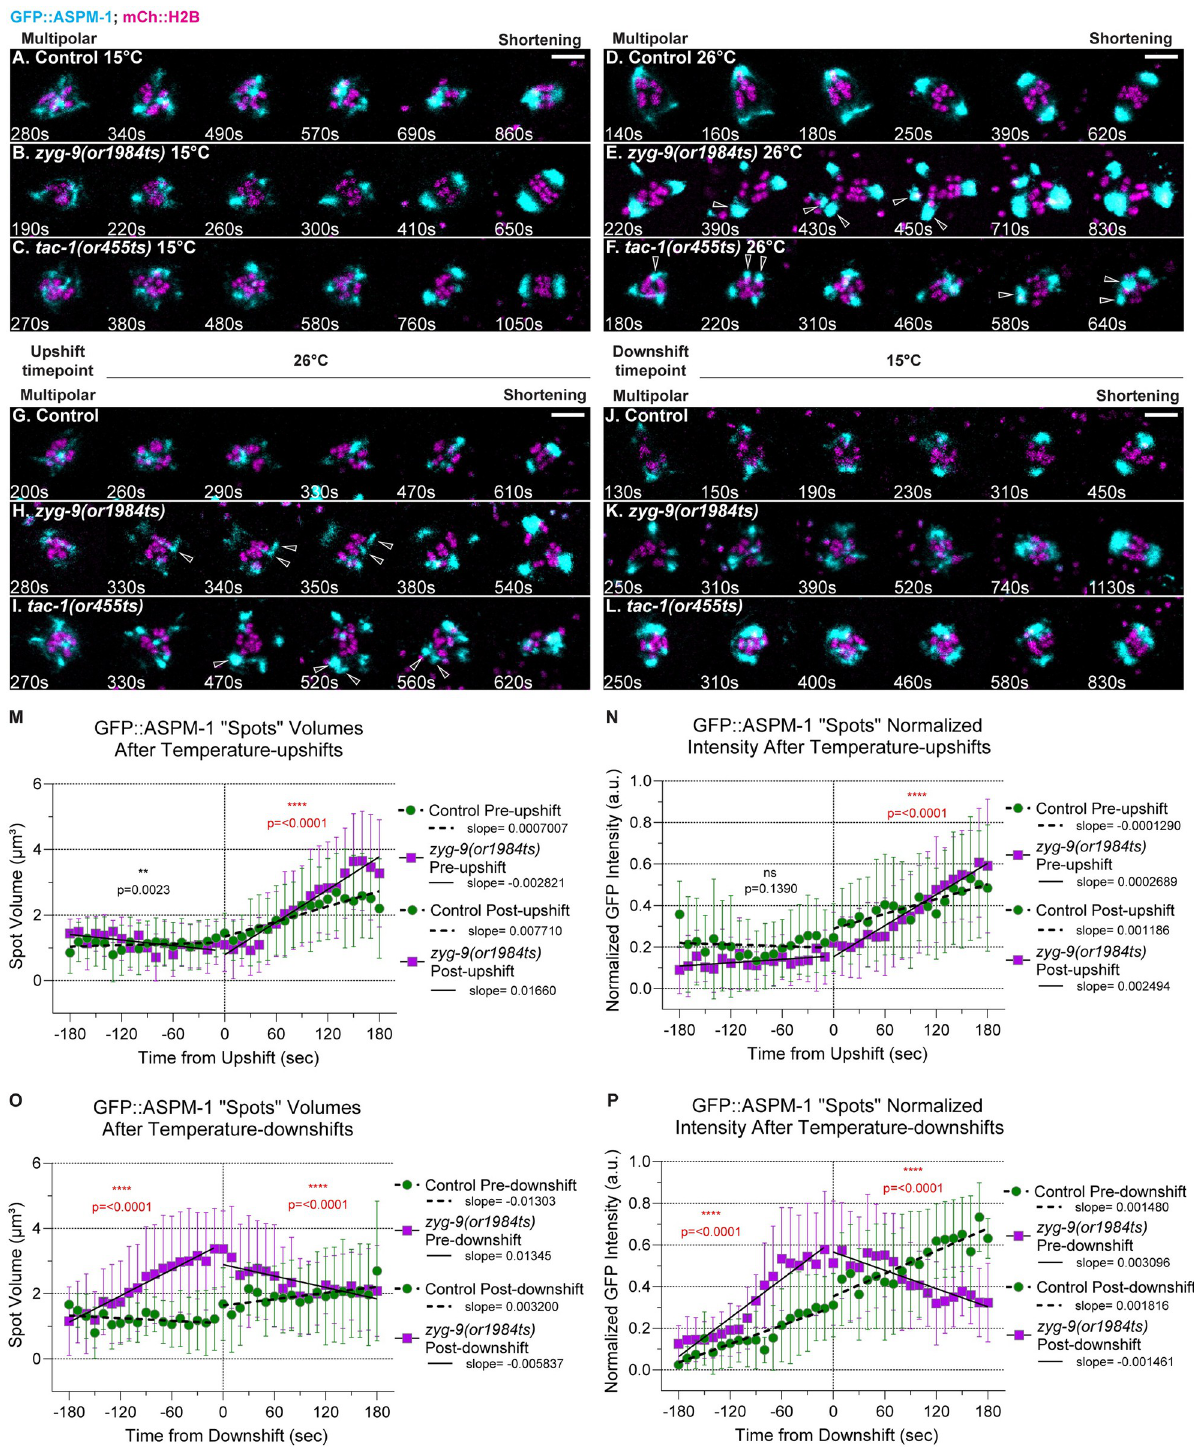
Fig 4. ZYG-9 and TAC-1 prevent the splitting of early pole foci and limit their growth during meiosis I bipolar spindle assembly. (A-L) Time- lapse maximum intensity projection images of live control and TS mutant oocytes expressing GFP::ASPM-1 and mCherry::H2B to mark spindle poles and chromosomes, at 15˚C (A-C), at 26˚C (D-F), and upshifted to 26˚C (G-I) or downshifted to 15˚C (J-L) during the multipolar stage. Montage frames highlight pole coalescence dynamics during the multipolar stage through to the onset of spindle shortening. Ooctes with extra spindle poles indicated with hollow arrowheads. (M-P) Quantification of control and zyg-9(or1984ts) GFP::ASPM-1 foci volume and integrated pixel intensity